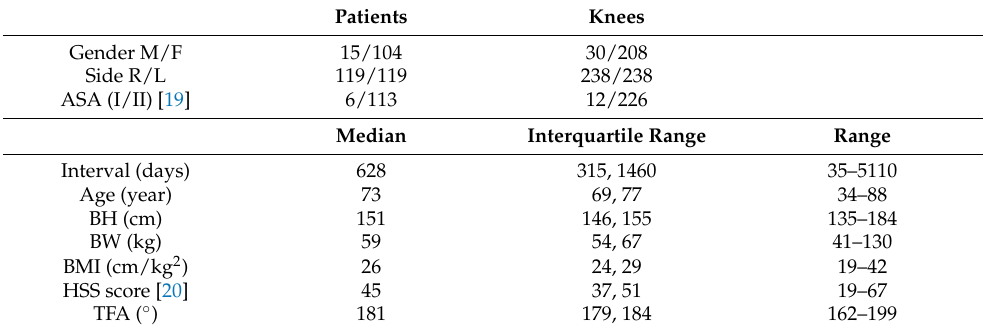
Table 1. Patients’ background